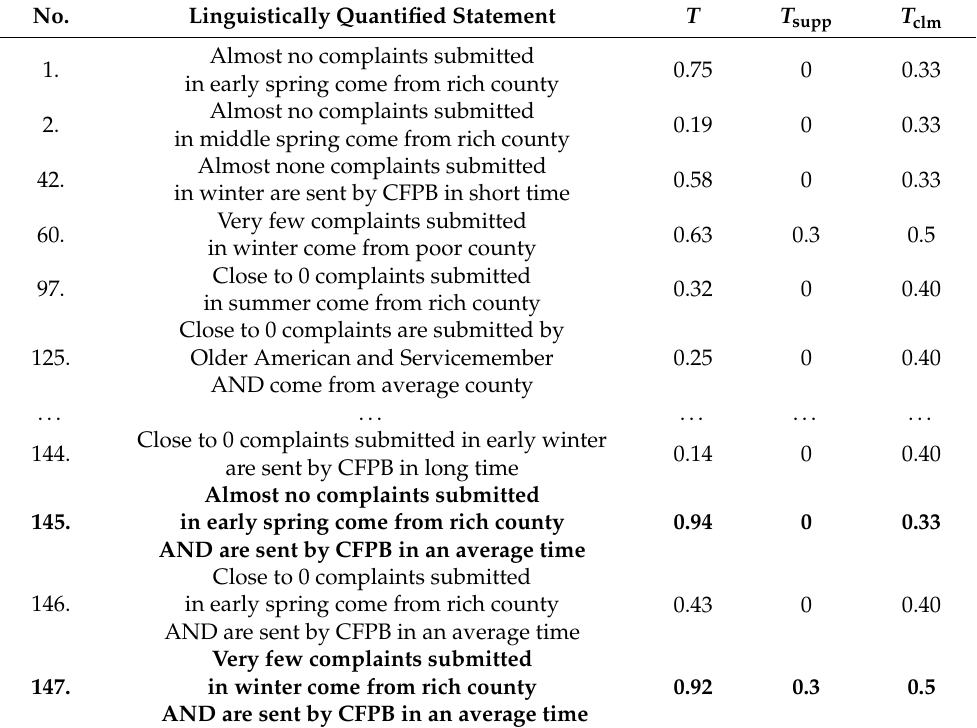
Table 2. Linguistically quantified statements 1.–147. generated with degrees of truth T and T supp , T clm measures (see (12) and (13)). The statements 145. and 147. that detected outliers, are